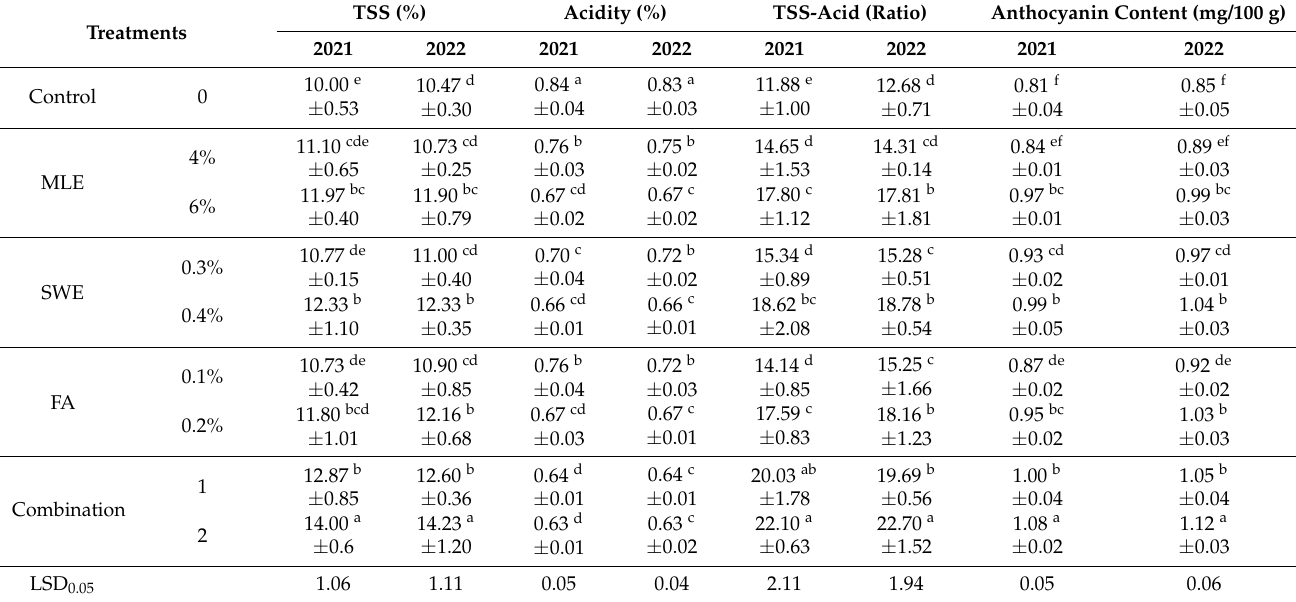
Table 5. The influence of the spraying of MLE, SWE and FA and their combinations on fruit juice TSS, acidity, TSS-acid ratio and peel anthocyanin content of apple cv. Anna during 2021 and 2022.